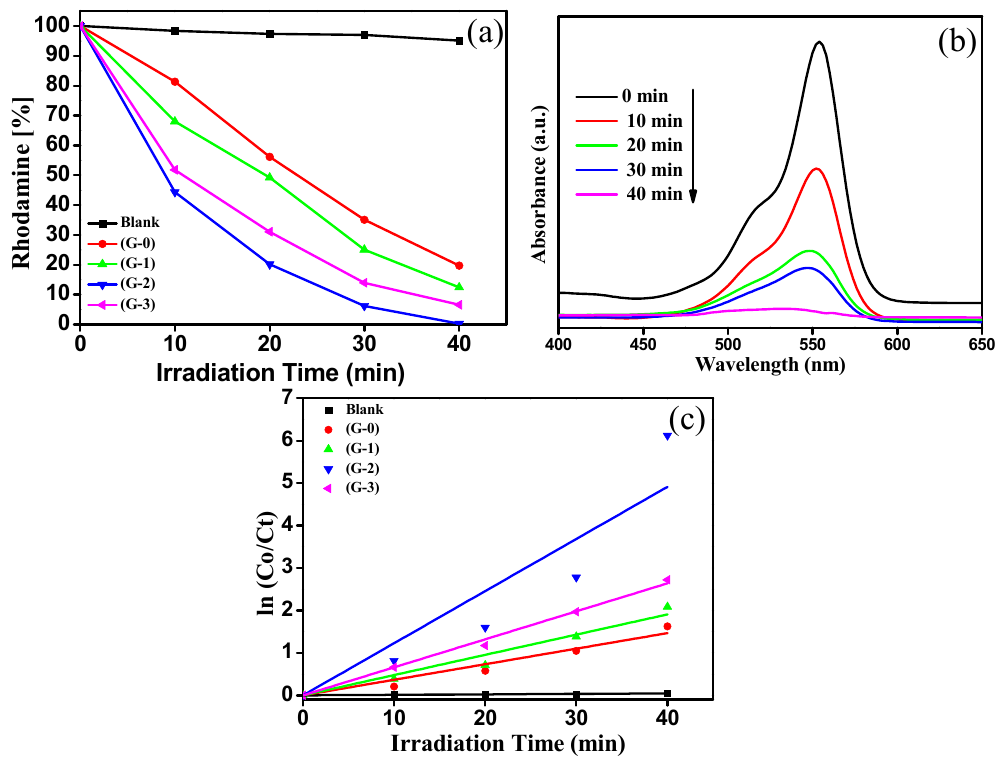
Figure 8. ( a ) Degradation (%) of RhB vs.irradiation time (min), ( b ) UV-visible absorption spectra of RhB exposed to natural sunlight for different time intervals, and ( c ) ln(C 0 /C t )vs. irradiation time (min). Table 1. Band gap and photocatalytic activity of TiO 2 and Cu-TiO 2 photocatalyst.